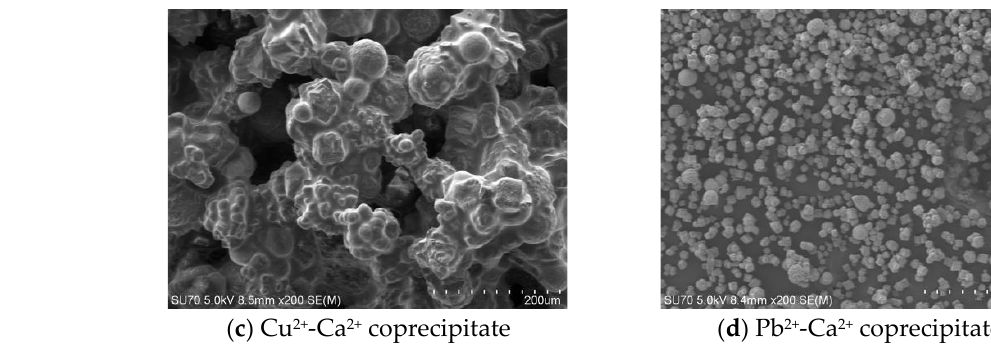
Figure 10. SEM images of precipitates.